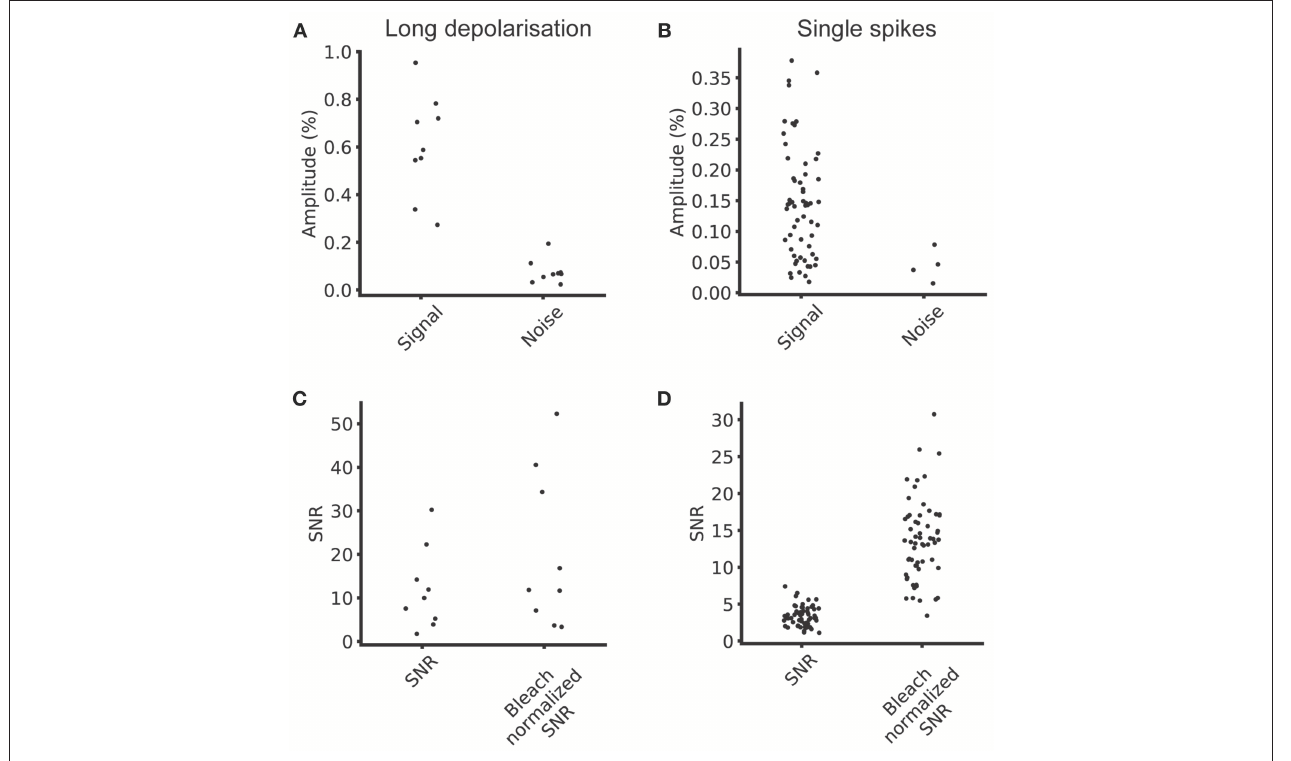
FIGURE 4 | Signal and noise levels. (A) Average signal and noise amplitudes for individual cells for five repeats at 100Hz. (B) Single spike signal amplitude and noise amplitude for five repeats at 100Hz. (C) SNR and bleach corrected SNR for long depolarizing stimulus. (D) SNR and bleach normalized SNR for single spike